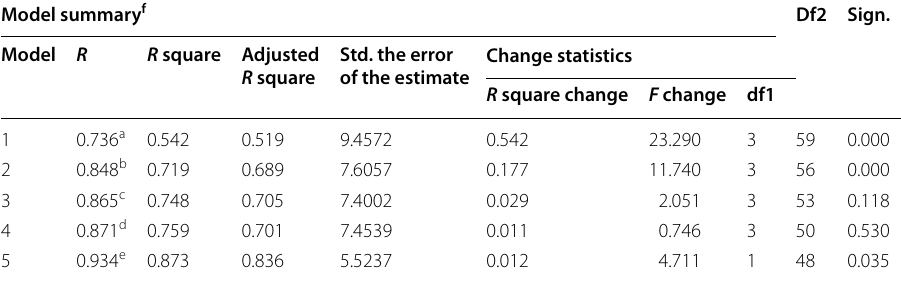
Table 5 Model summary of knowledge and technology outputs